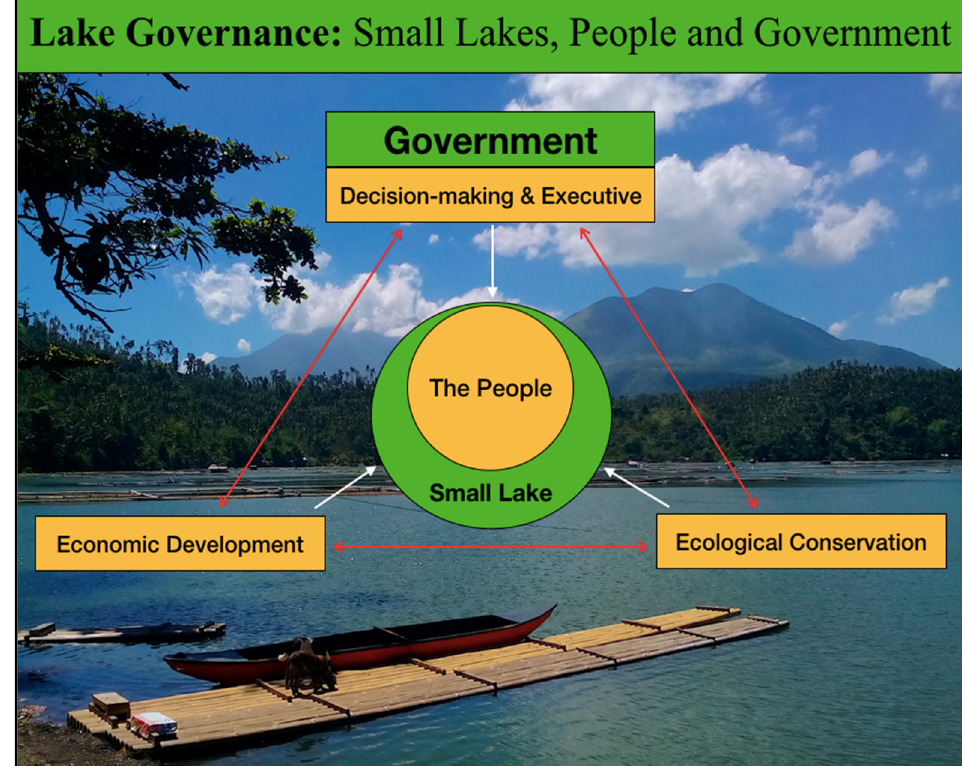
Figure 1. Lake governance: small lakes, people and government.